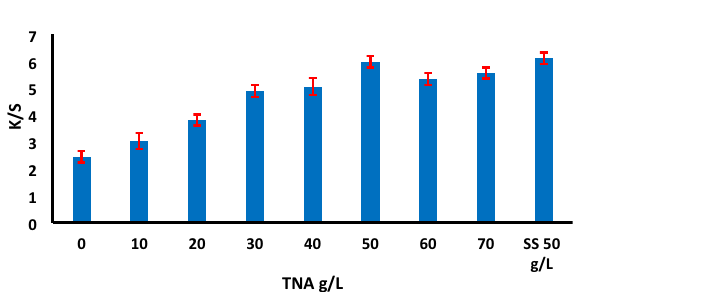
Figure 3. Schematic diagram of the interaction of TNA salt with cotton fabric during exhaustion dyeing with reactive dye.